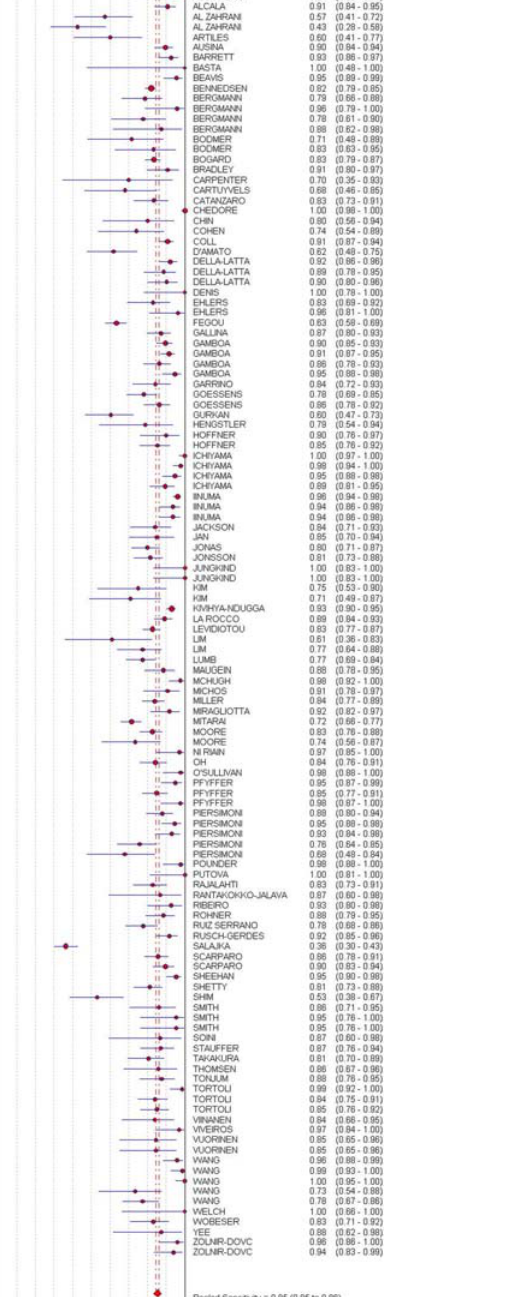
Figure 3. Forest plot of specificity estimates and 95% CI. Point estimates of specificity from each study are shown as solid circles. The solid lines represent the 95% confidence intervals (CI). Circles are proportional to study size. The pooled estimate is denoted by the diamond at the bottom.